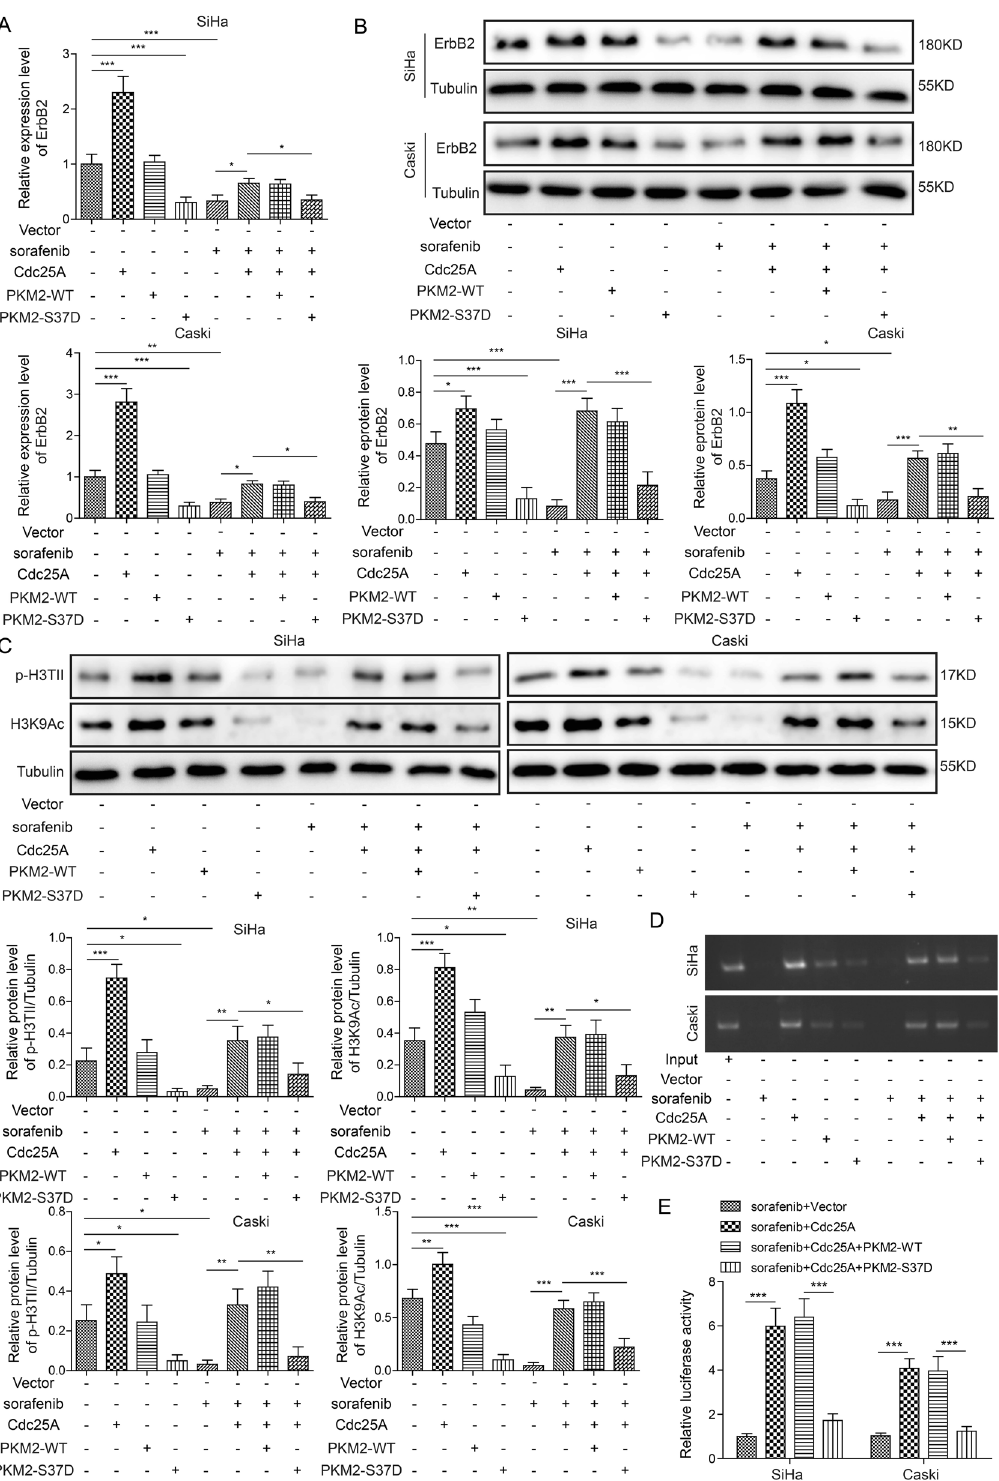
Fig. 6 Cdc25A regulated ErbB2 via PKM2 – pH3T11 – H3K9Ac pathway. A Relative ErbB2 mRNA levels in transfected cells with or without sorafenib treatment. B Relative ErbB2 protein levels in transfected cells with or without sorafenib treatment. C Relative protein levels of p-H3T11 and H3K9Ac in transfected cells with or without sorafenib treatment. D ChIP analysis of the binding between H3K9Ac and the ErbB2 promoter. E Relative luciferase activities of ErbB2 in transfected cells following sorafenib treatment. Each experiment was repeated three times. * P < 0.05; ** P < 0.01; *** P < 0.001.